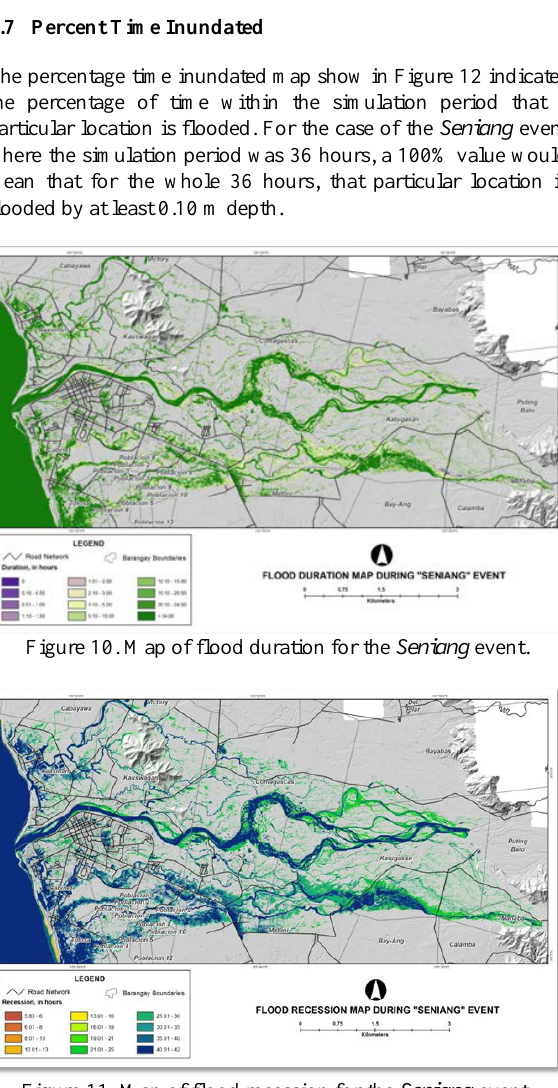
Figure 11. Map of flood recession for the Seniang event.